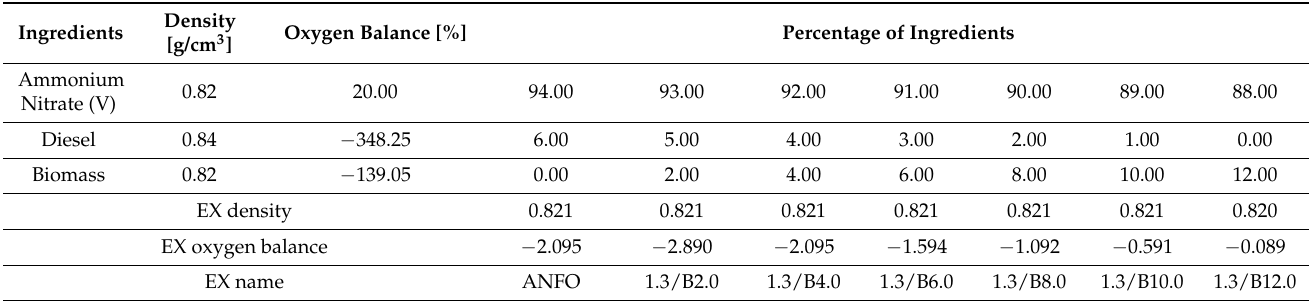
Table 3. Oxygen balance and EX density of ANFO type with addition of biomass for variant 1.3.